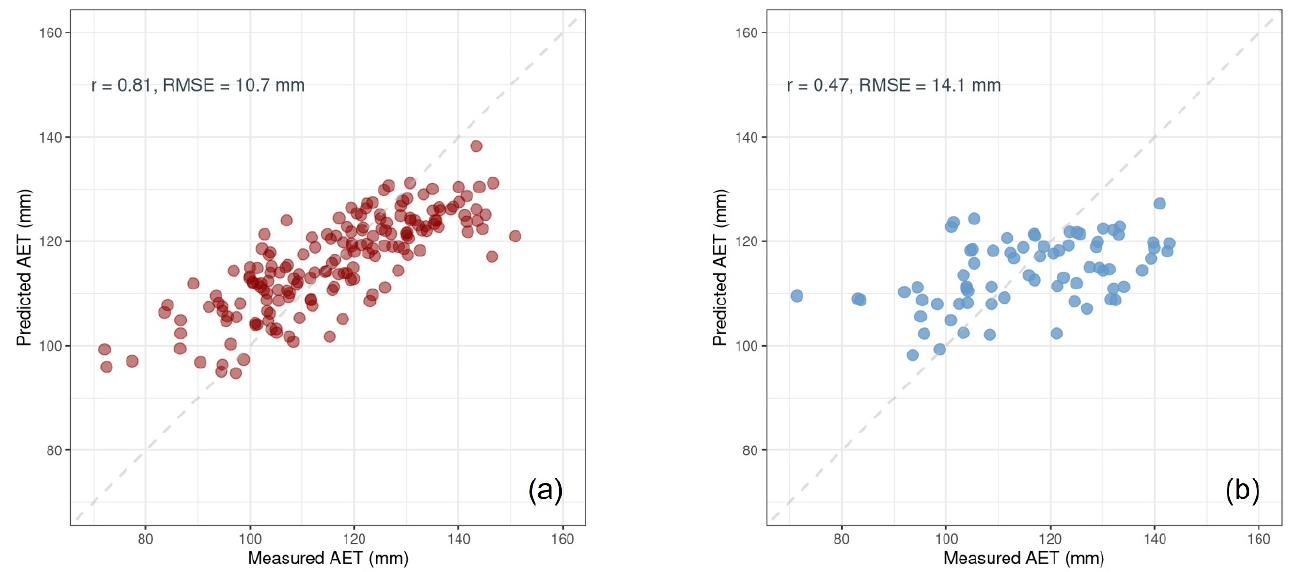
Figure 8. Relationship between the observed and predicted AET values for ( a ) the training set (80%) and ( b ) the testing set (20%).